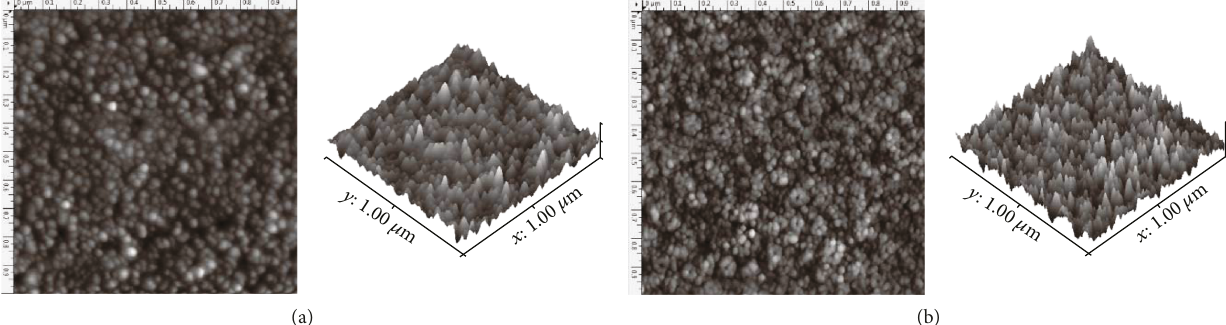
Figure 7: The 2D and 3D AFM images of (a) SG-TiO